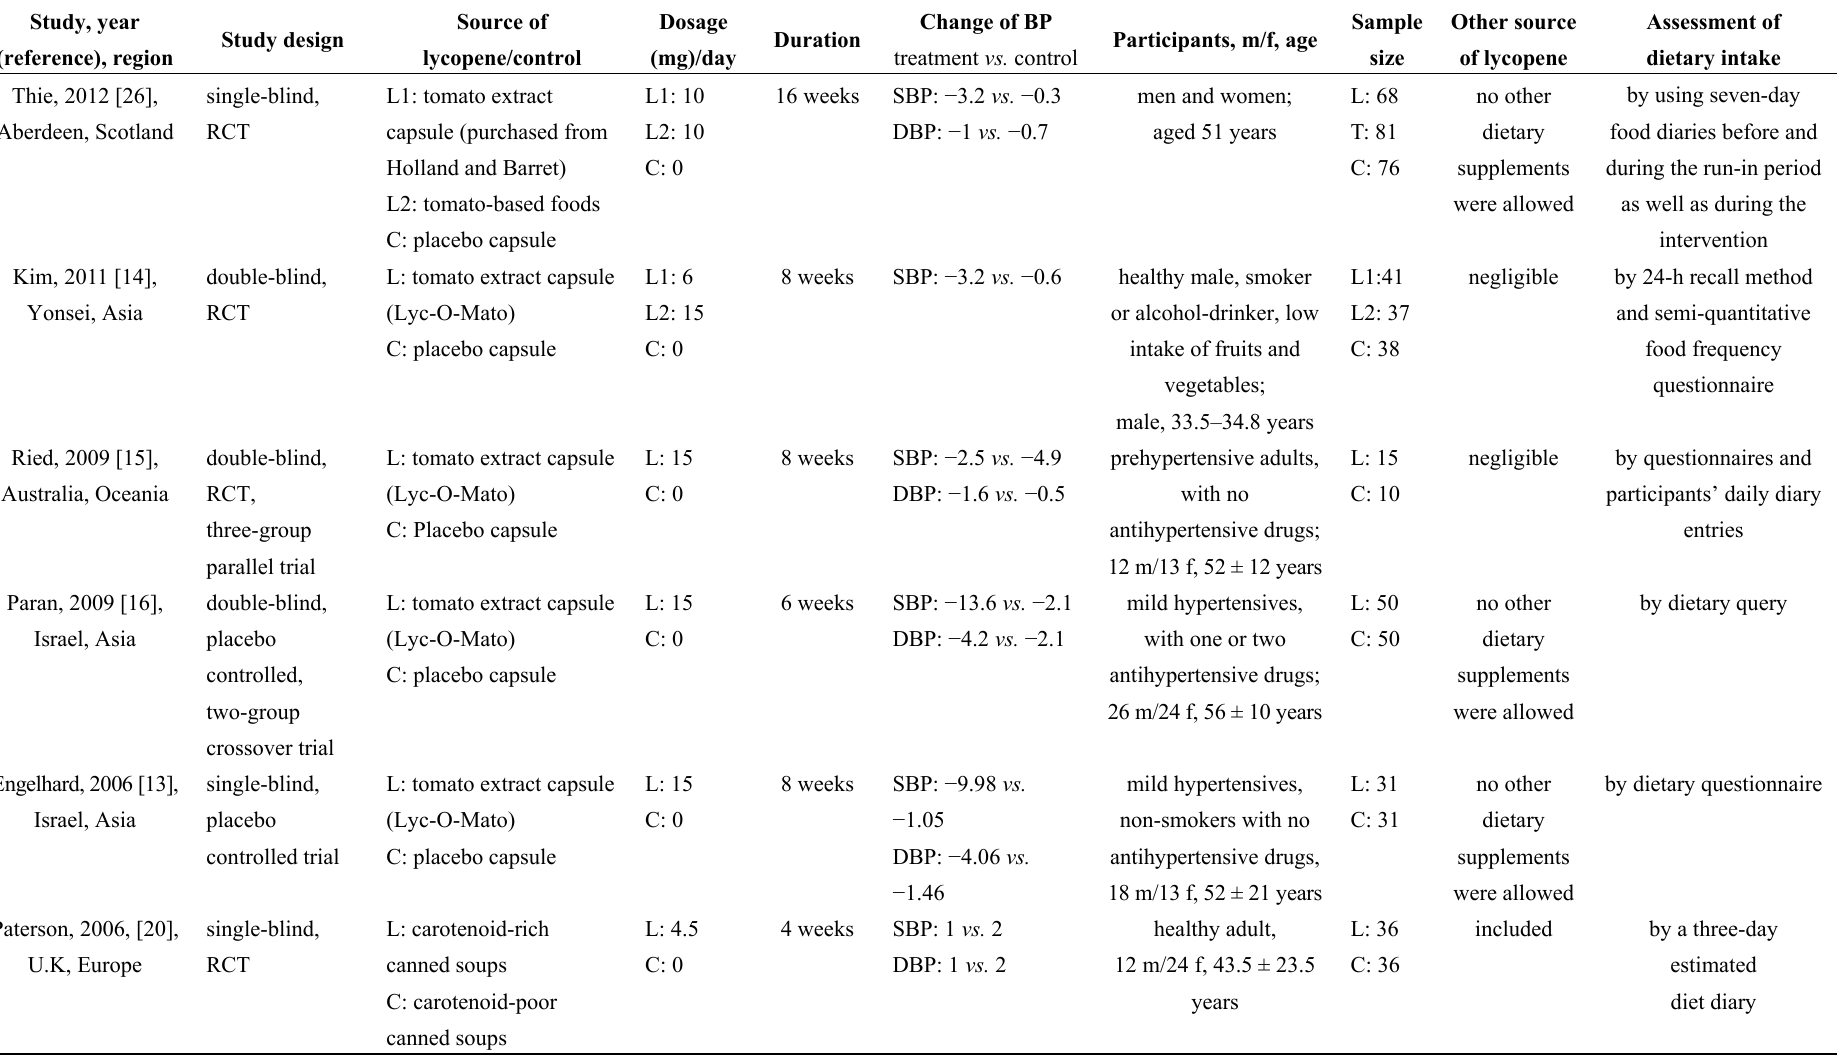
Table 1. Characteristics of included